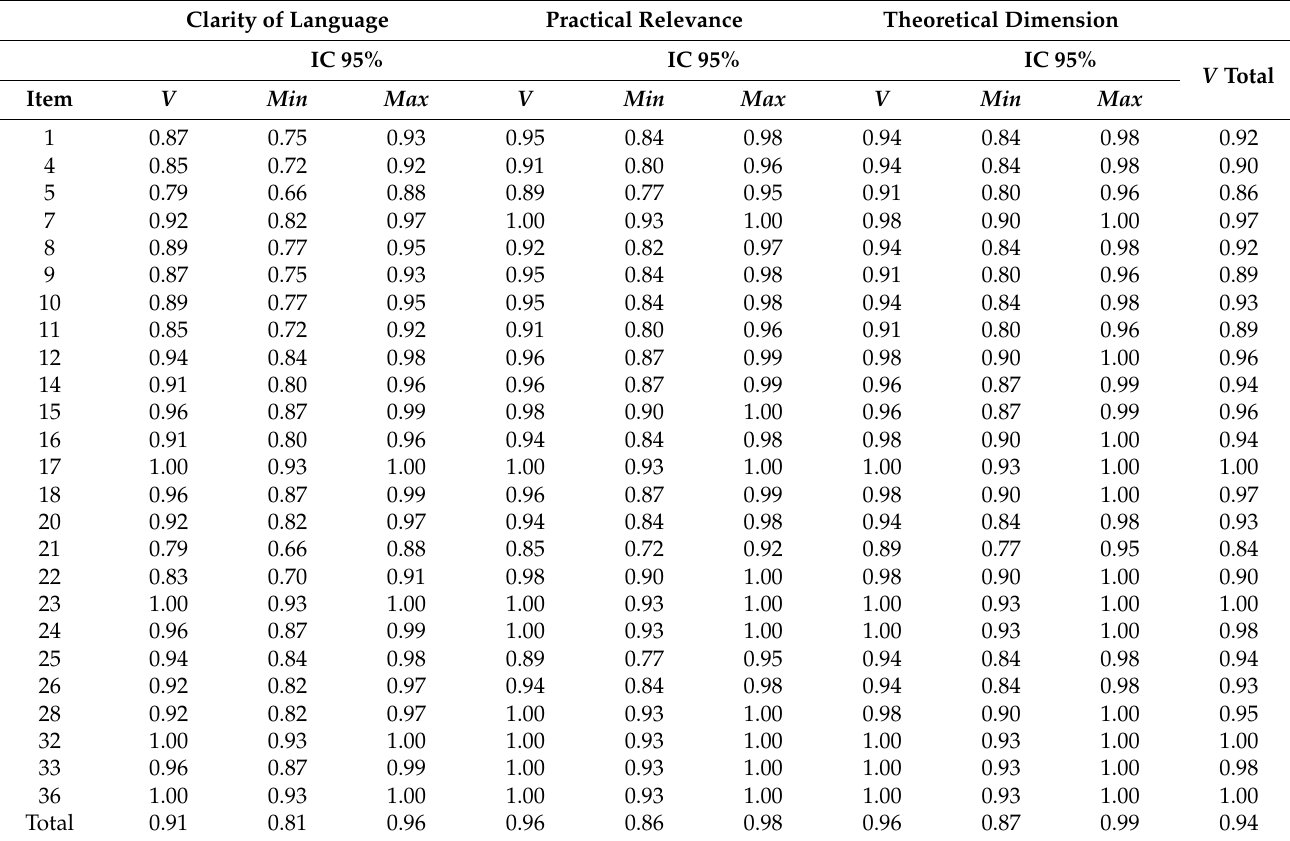
Table 1. Aiken‘s V